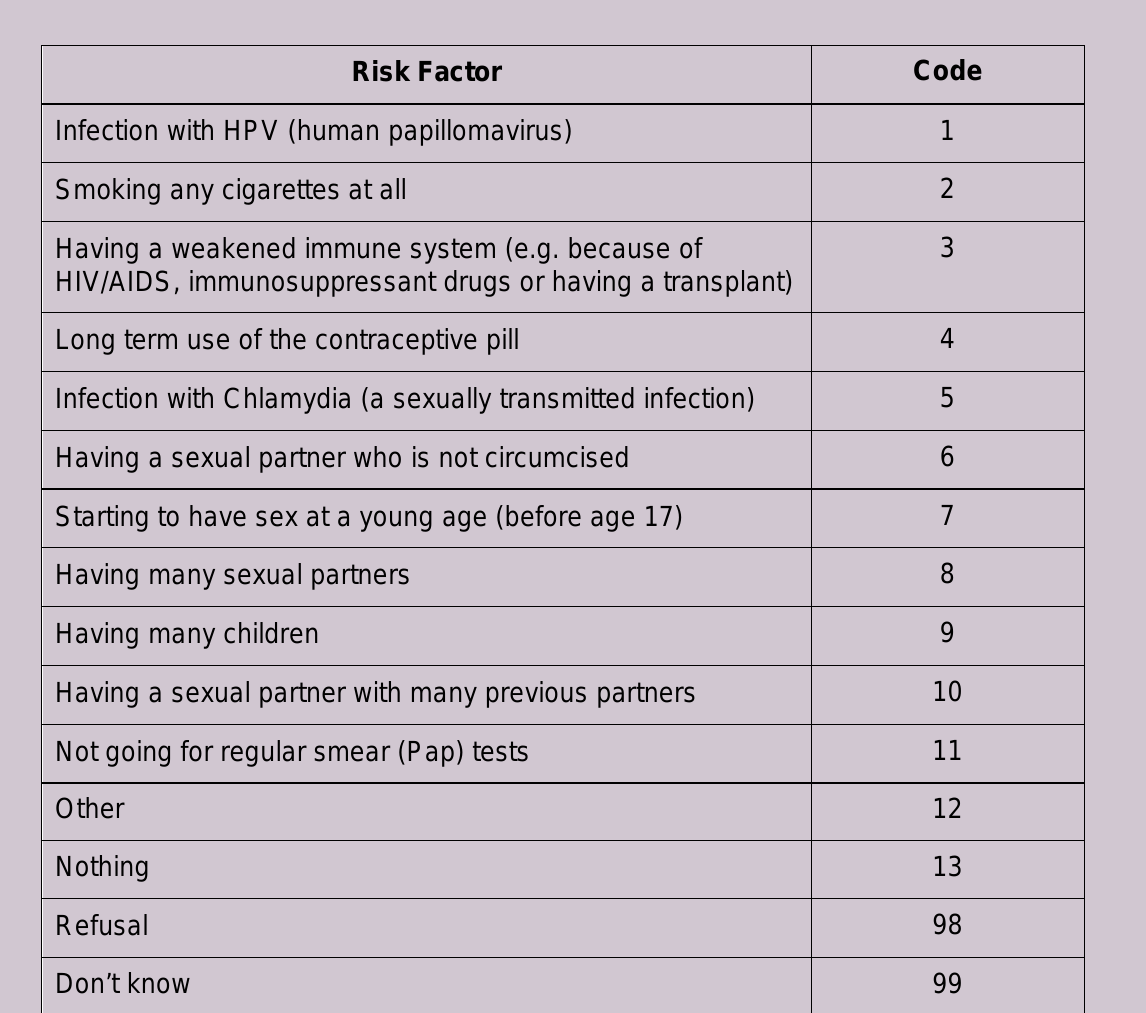
Cervical Cancer Awareness Measure Toolkit Version 2.1 Updated